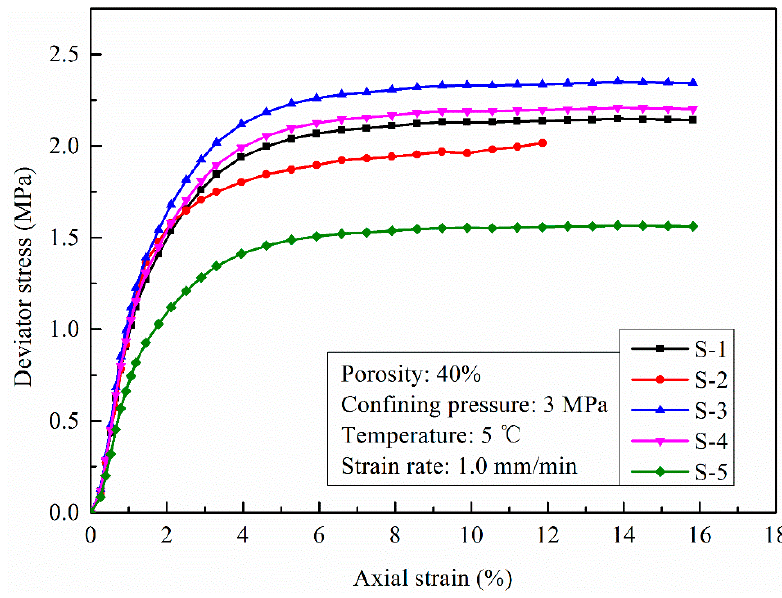
Figure 5. Stress–strain curves of HBMS at different drilling depths. Energies 2019 , 12 , x FOR PEER REVIEW